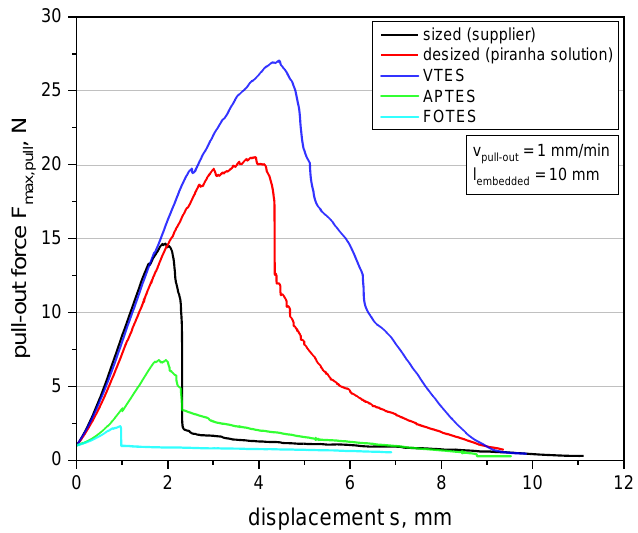
Figure 5. Force–displacement curve determined from the FBPO test on glass fiber (GF) bundles with the polydimethylsiloxane (PDMS) matrix for different fiber surface modifications. Table 3. Maximum pull-out force F max,pull from FBPO tests for different surface-treated GF bundles combined with the PDMS matrix. Surface Treatment